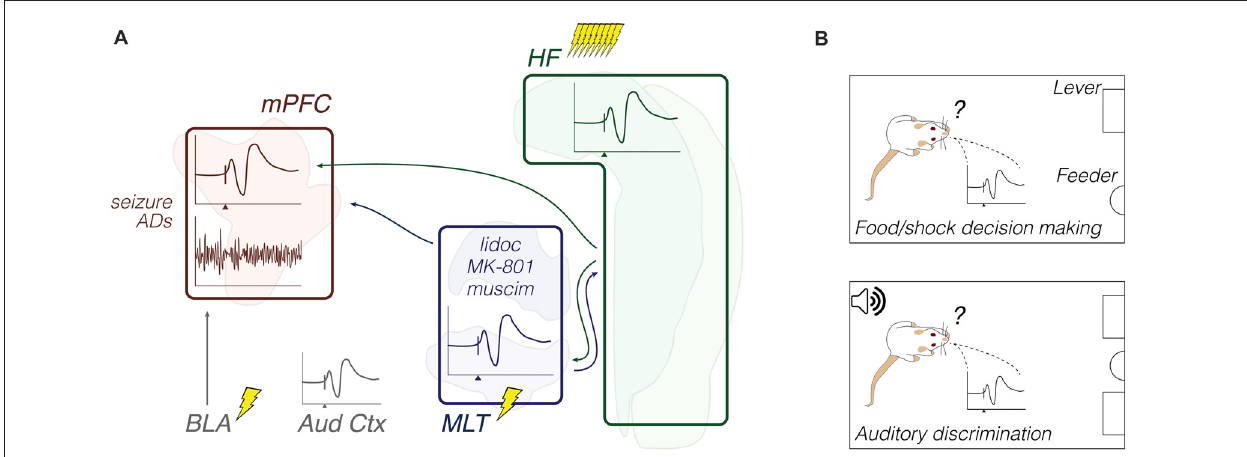
FIGURE 3 | Synaptic plasticity: methods and objects of study merged into a schematic summary. The figure portrays generic representations of techniques reviewed in the “Synaptic plasticity” subsection. Arrows from the HF are generically positioned, i.e., no distinction is made between dorsal, intermediate and ventral domains. Outlines of brain areas are based on Figure 1 . (A) In vivo electrophysiology, intracerebral electrical stimulation, and pharmacological manipulations. Experiments evaluated the prefrontal and auditory cortical field potential reactivity to afferent electrical stimuli or sound stimuli, including during drug effects and after induction of synaptic plasticity or seizure activity. Lightning icons represent single electrical pulses, or trains of pulses. Representative prefrontal cortical voltage traces: evoked (top) and spontaneous field potentials (bottom), with the x -axis arrowhead representing afferent stimuli (e.g., Hugues and Garcia, 2007; Kiss et al., 2011b). Field potential responses recorded from other brain sites are also illustrated (e.g., Grupe et al., 2014). (B) Chronic electrophysiology (field potential responses) during a food vs. trigeminal shock operant task (top), and a two-lever auditory discrimination task (bottom). Experiments evaluated relationships between behavioral performance and evoked field potential responses (e.g., López-Ramos et al., 2015). Abbreviations: ADs, after-discharges; Aud Ctx, auditory cortex; BLA, basolateral amygdala; HF, hippocampal formation; lidoc, lidocaine; MLT, midline/paramidline thalamus; mPFC, medial prefrontal cortex; muscim,